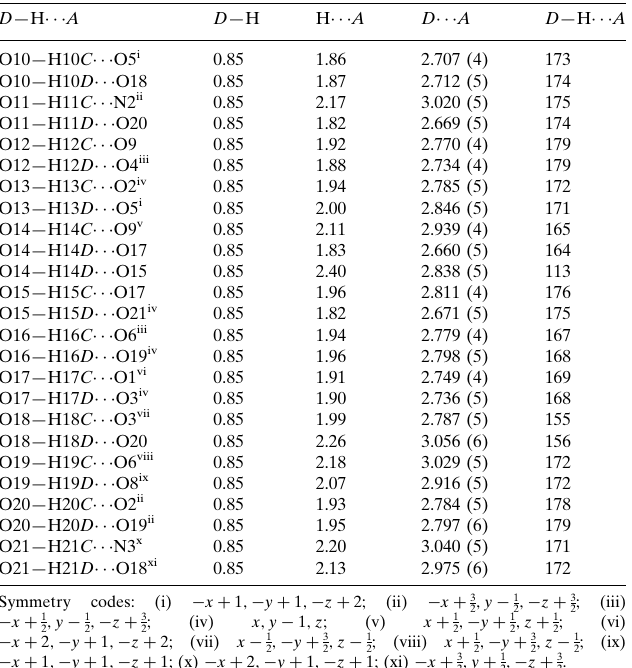
by crystallographic inversion symmetry. The Eu atom adopts a distorted dodecahedral coordination arising from one O- bonded 2,2 0 -azinodibenzenesulfonate ligand and seven water molecules. In the crystal structure, the components are linked